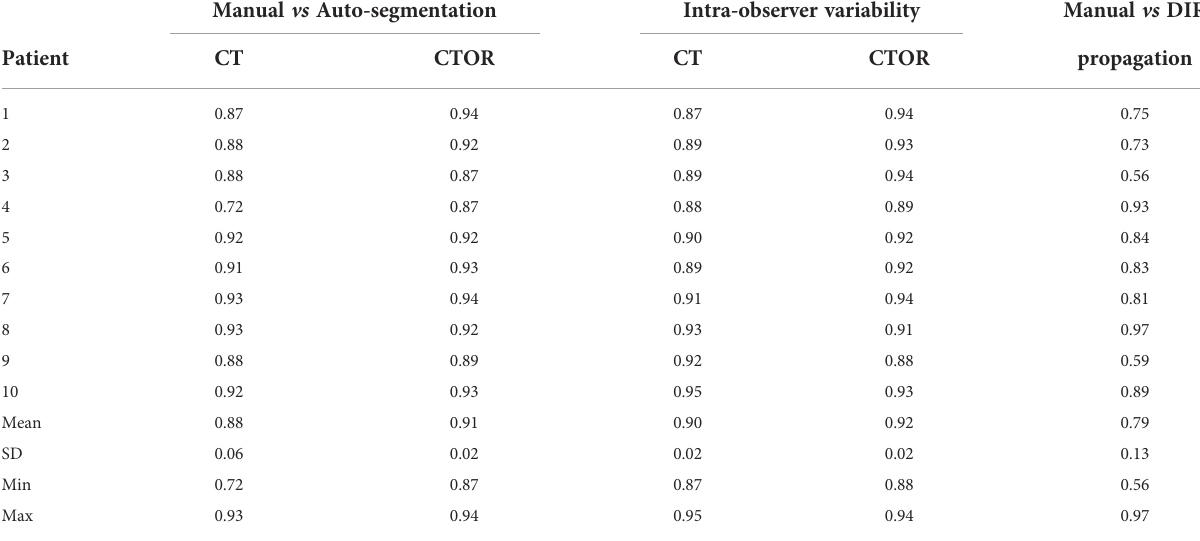
TABLE 2 Dice similarity coef fi cients (DSC) for the combination of stomach and duodenum in 10 test pairs of CT and CTOR from different patients. Manual vs Auto-segmentation